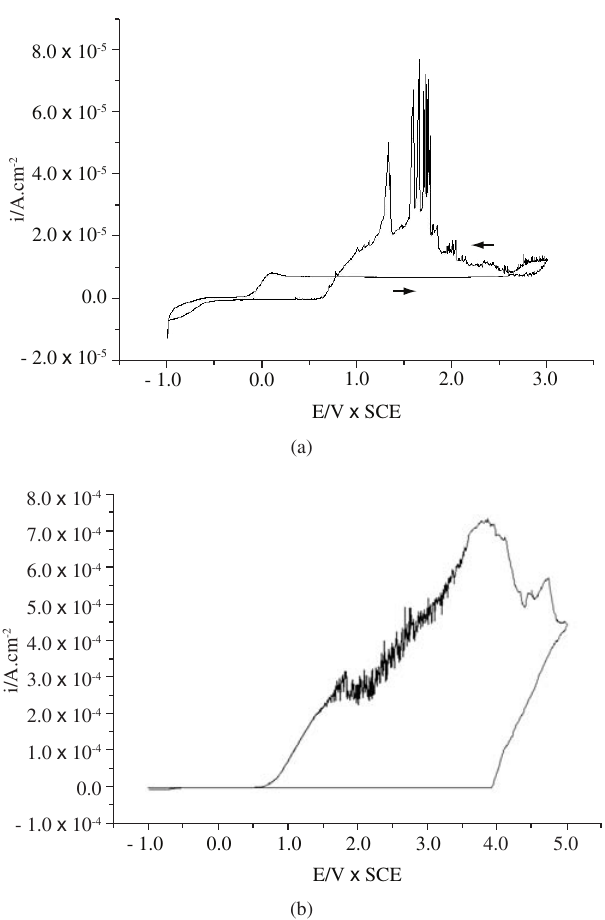
Figure 3. Voltammetric curves in the bromide-containing citric acid at 0.05 Vs -1 ; a) Ti6Al4V (- 1.0 to 4.0 V); and b) Ti (- 1.0 to 5.0